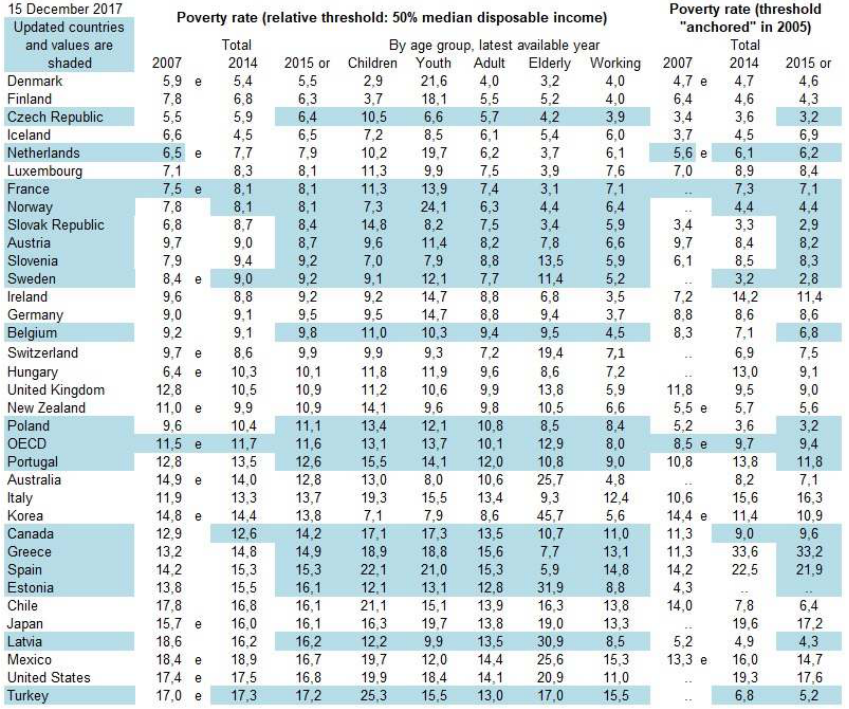
Table 2: Poverty Rates in the OECD